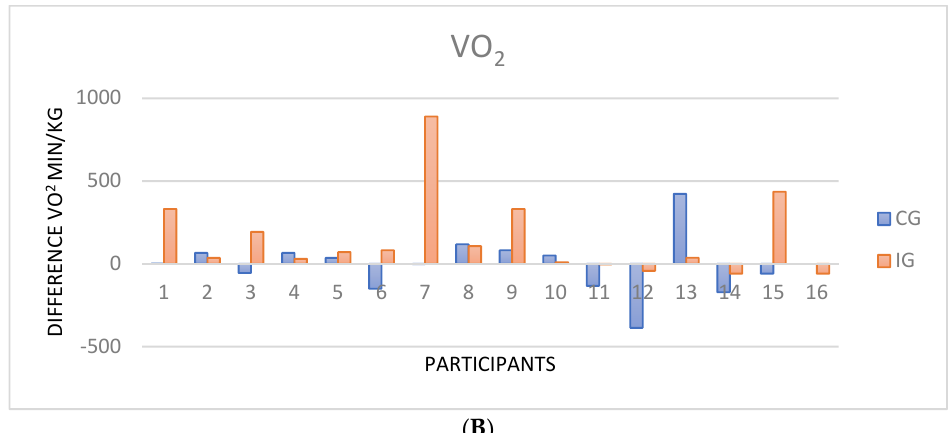
Figure 2. ( A ) The y -axis represents walked distance difference before and after HPRP, and the x -axis shows the subjects by groups. ( B ) The y -axis represents VO 2 /min/kg differences before and after HPRP, and the x -axis shows the subjects by groups.